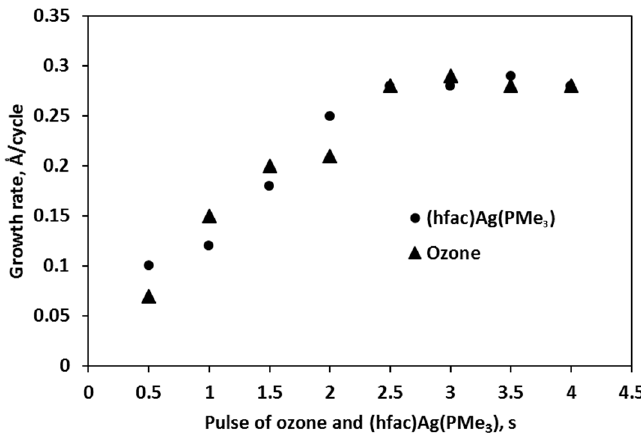
Figure 2. The effect of ozone and (hfac)Ag(PMe 3 ) pulse time on the growth rate of silver oxide at 200 °C reactor temperature.